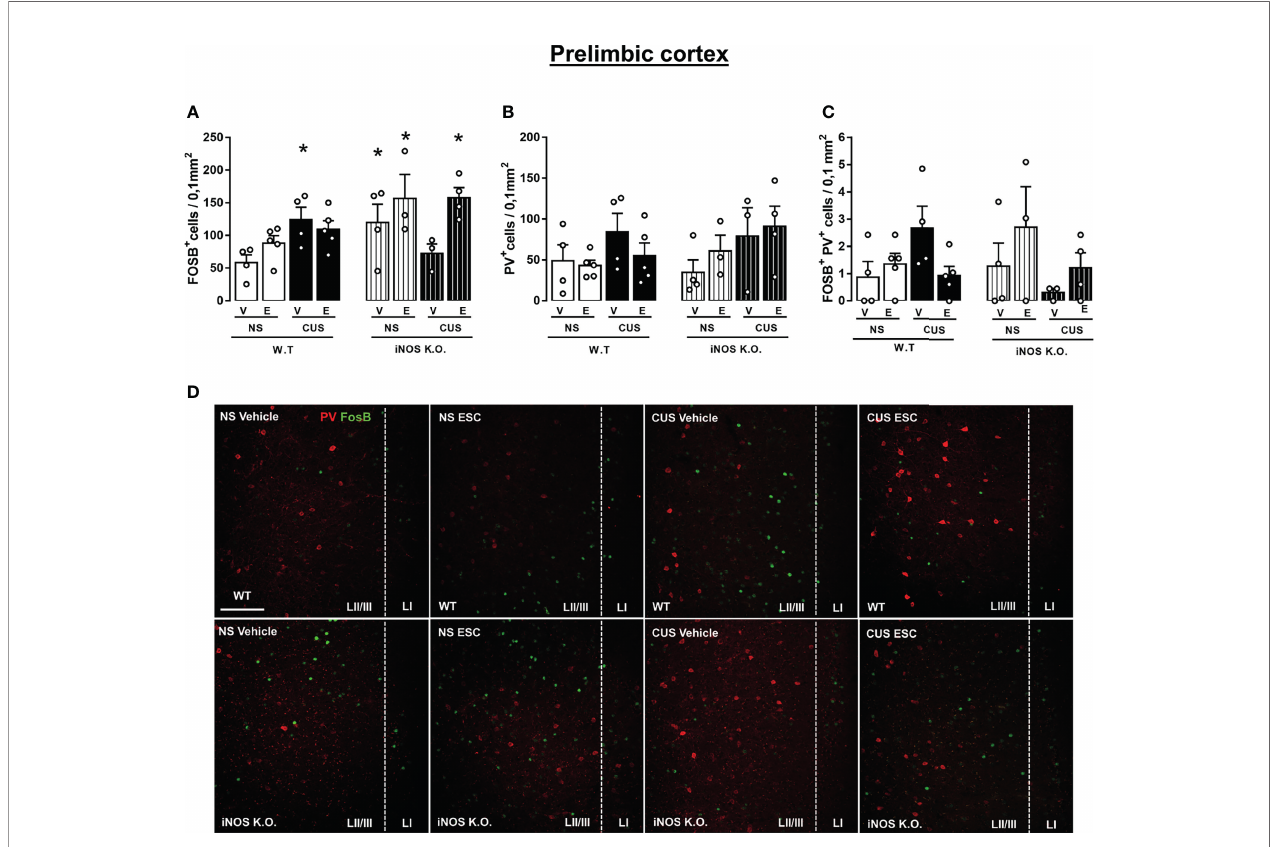
FIGURE 7 | Escitalopram does not modify the parvalbumin-positive cells recruitment on prelimbic cortex (PrL) of iNOS KO mice. FOSB + cells quanti fi cation on PrL (A) , PV+ cells density on PrL (B) and FOSB + PV + colocalization density on PrL and IL (C) . Representative images showing FOSB+ and PV+ cells of all experimental groups analyzed ( D ; scale bar = 50 µm). N=4,5,4,5,4,3,3,4, respectively. *p < 0,05 from WT non-stressed